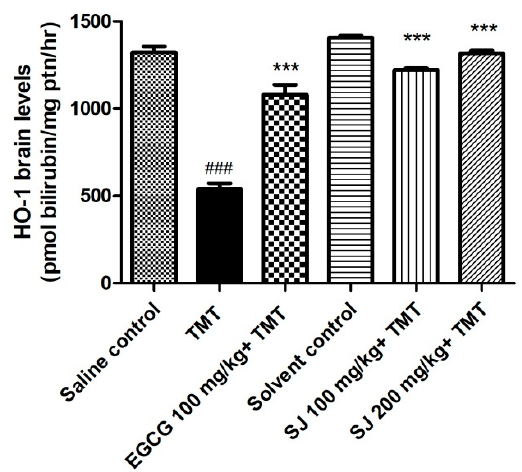
Figure 9. HO-1 levels in the brains of mice administering two different doses of SJ extract before being injected with TMT. SJ 200 mg/kg group demonstrated highly significant elevation in HO-1 levels compared to TMT treated group. Statistical analysis was done via one-way ANOVA then Bonferroni’s method. *** p < 0.001 relative to TMT treated group and ### p < 0.001 relative to saline control group.